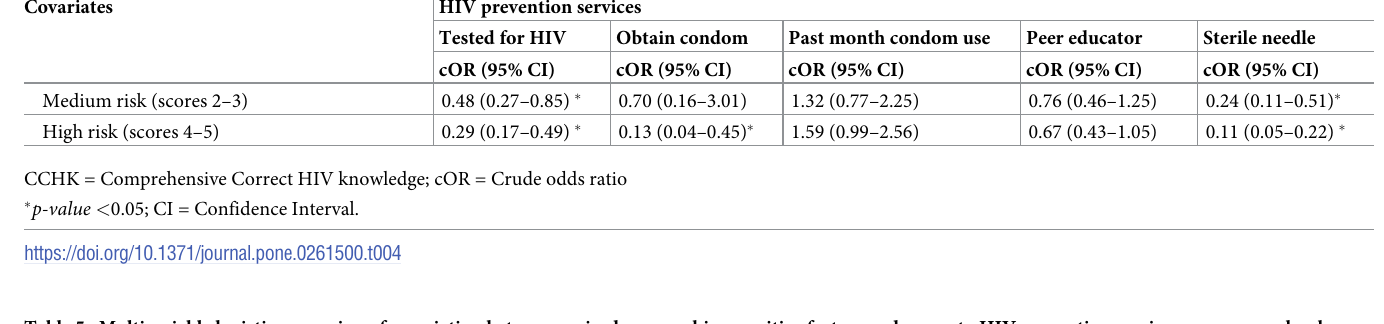
Table 5. Multivariable logistic regression of association between socio-demographic, cognitive factors and access to HIV prevention services among people who inject drugs in Dar es Salaam, 2017, (N = 611).